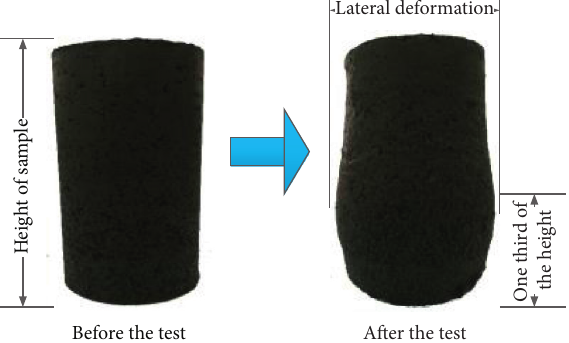
Figure 4: Comparative image of a sample before and after the